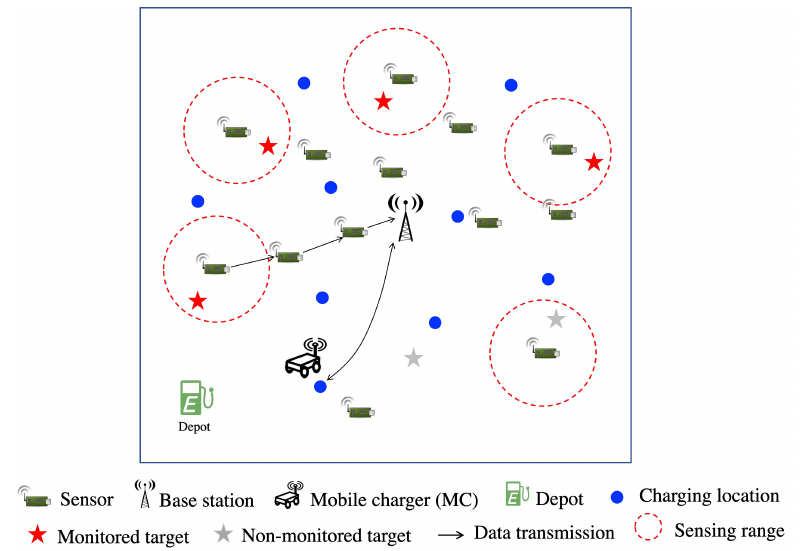
Figure 1. The network